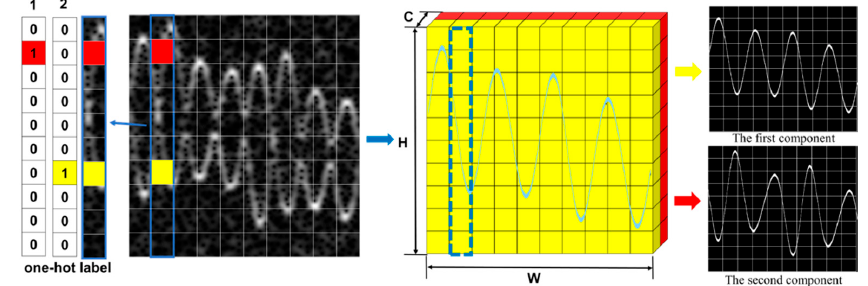
Figure 9. Column-based classification of a two-component m-D signal. For each visual m-D component, its vertical location at each column is estimated based on an ℎ -dimensional probability vector. The output of the CMDC branch is the reshaped classification results. The production of CMDC branch is the position set of all components with size 𝐶 × ℎ × 𝑤 , which is given by